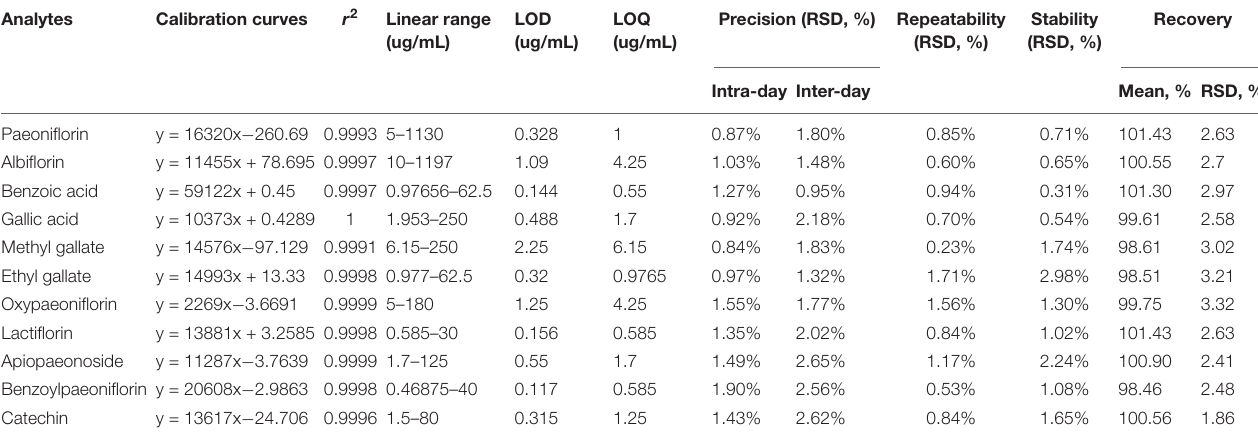
FIGURE 3 | The TIC chromatogram of P. lactiflora root in negative mode. TABLE 1 | Method validation of 11 reference